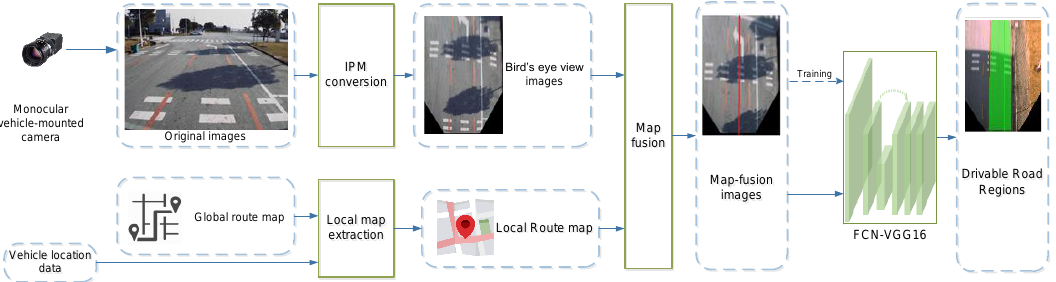
Figure 2. Overall Framework of the drivable road region detection based on map-fusion and monocular camera.